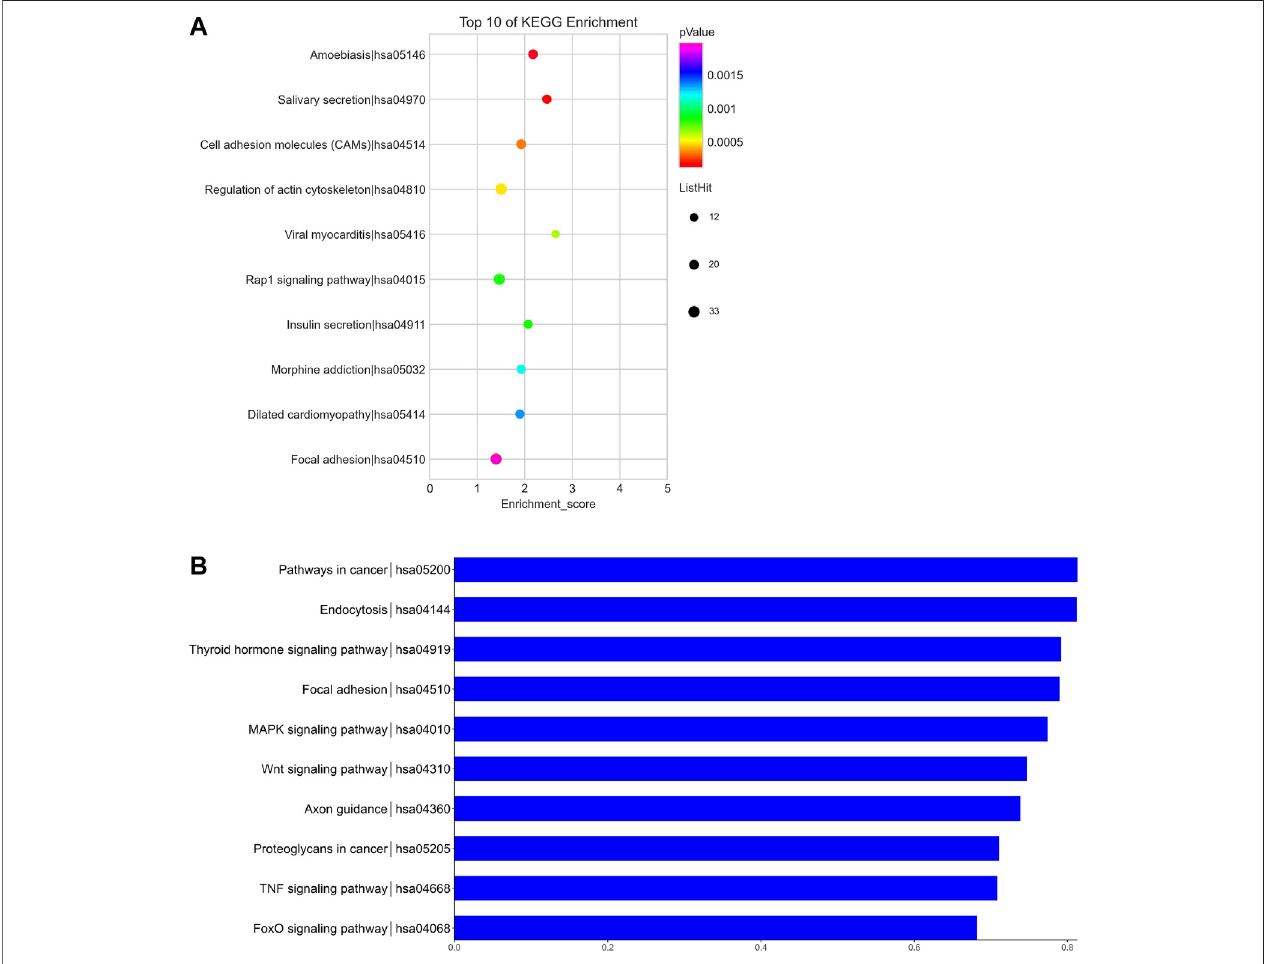
FIGURE 6 | KEGG pathway analysis of circRNAs and miRNAs. Biological roles of the differentially expressed circRNAs (A) and miRNAs (B) . Biological roles of the differentiallyexpressedcircRNAsincludeamebiasis,salivarysecretion,celladhesionmolecules(CAMs),andsoon.BiologicalrolesofthedifferentiallyexpressedmiRNAs include pathways in cancer, endocytosis, thyroid hormone signaling pathway, and so